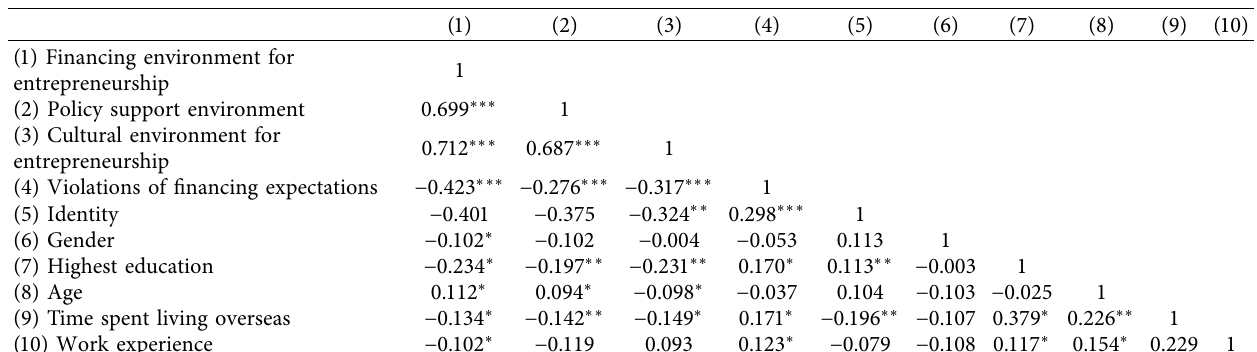
Table 3: Correlation